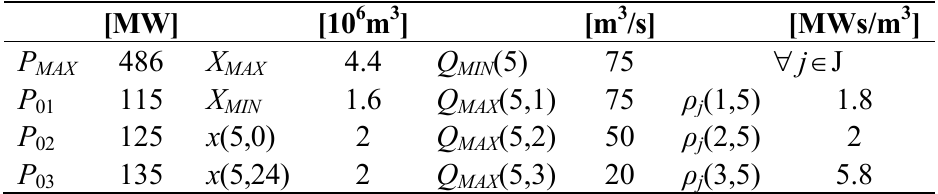
Table 2. Parameters for reservoir 5 and HPP